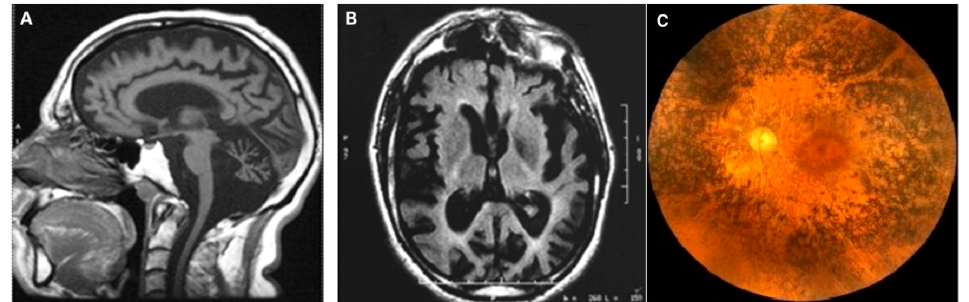
Figure 3. NARP/MILS. ( A , B ). FLAIR T2-weighted sagittal and transverse sequences of a patient with NARP/MILS (modified from Lopez-Gallardo, 2009 [46]). Profound cortical atrophy with enlargement of the ventricular system; severe cerebellar atrophy. ( C ). Fundus oculi showing retinal dystrophy in a patient with NARP/MILS.